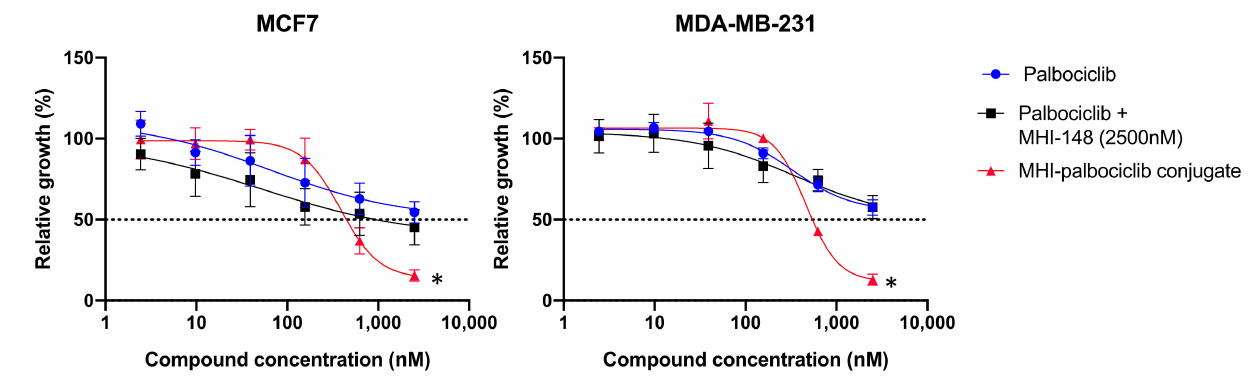
Figure 3. Inhibition of relative growth by MHI-palbociclib is significantly higher than the parent compound palbociclib, or the combination of palbociclib with unconjugated MHI-148 in breast cancer MCF-7 and MDA-MB-231 cell lines. Effects on breast cancer cell lines were measured after 3 days exposure to the compounds. Data presented are an average of at least three independent experiments, * p <